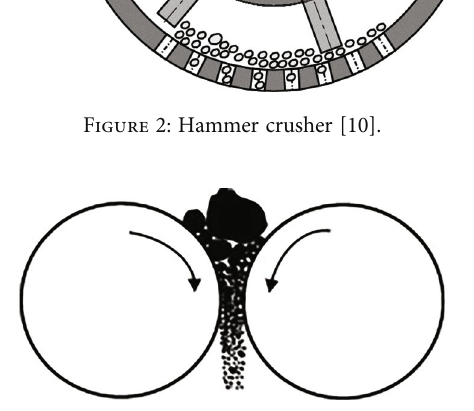
Figure 3: Roller crusher [11].